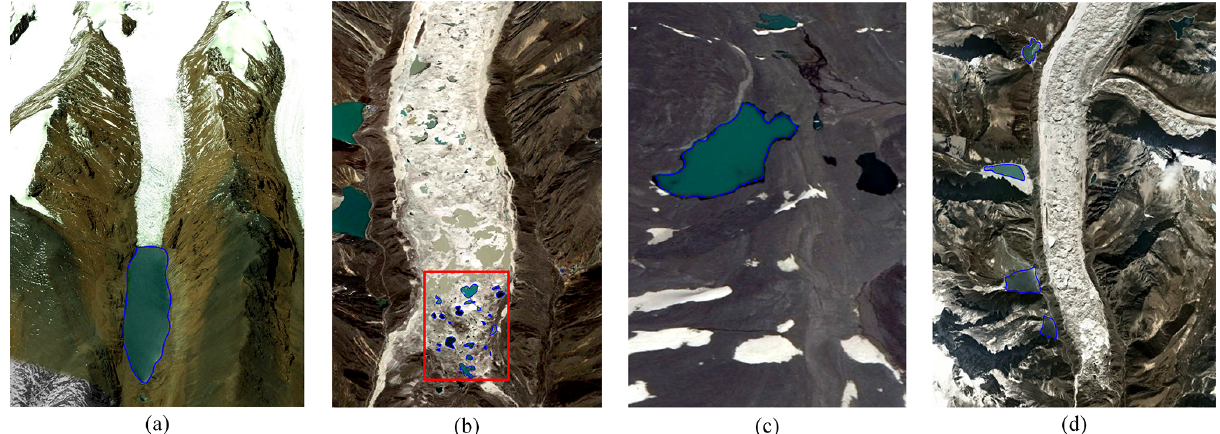
Figure A1. Examples of the various types of glacial lakes found in the HMA region: (a) proglacial lakes, which are connected to the parent glacier and usually impounded by a debris dam (usually a moraine or ice-cored moraine); (b) supraglacial lakes (denoted by the red rectangle), which develop on the glacier surface; (c) unconnected glacial lakes; and (d) ice-marginal lakes that are distributed on the edge of a glacier. Background images were acquired from © Google Earth and were obtained in 2009, 2011, 2012, and 2014, respectively. Glacial-lake outlines for each type are shown in blue.